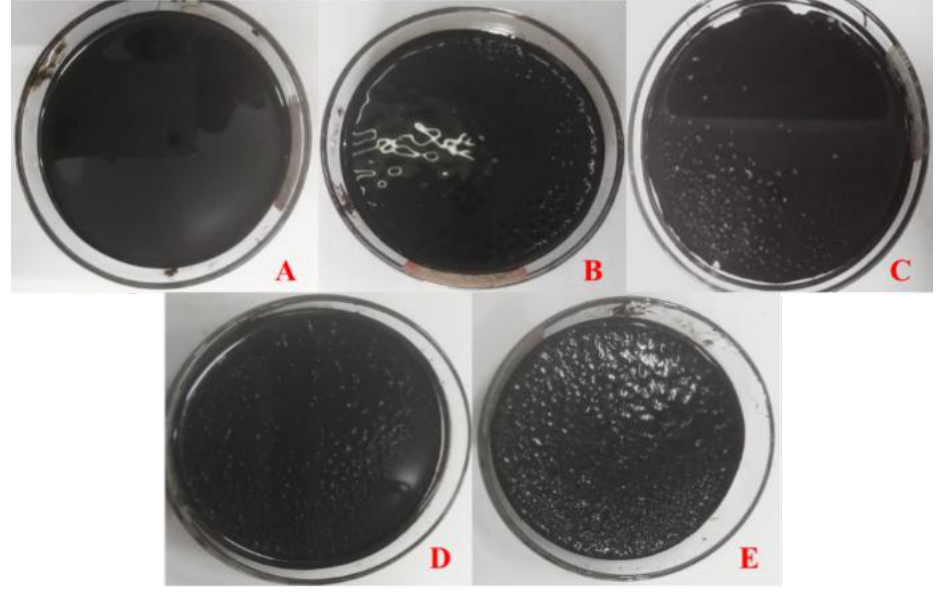
Figure 2. 70 # asphalt appearance before and after 7 days water solution immersion ( A )